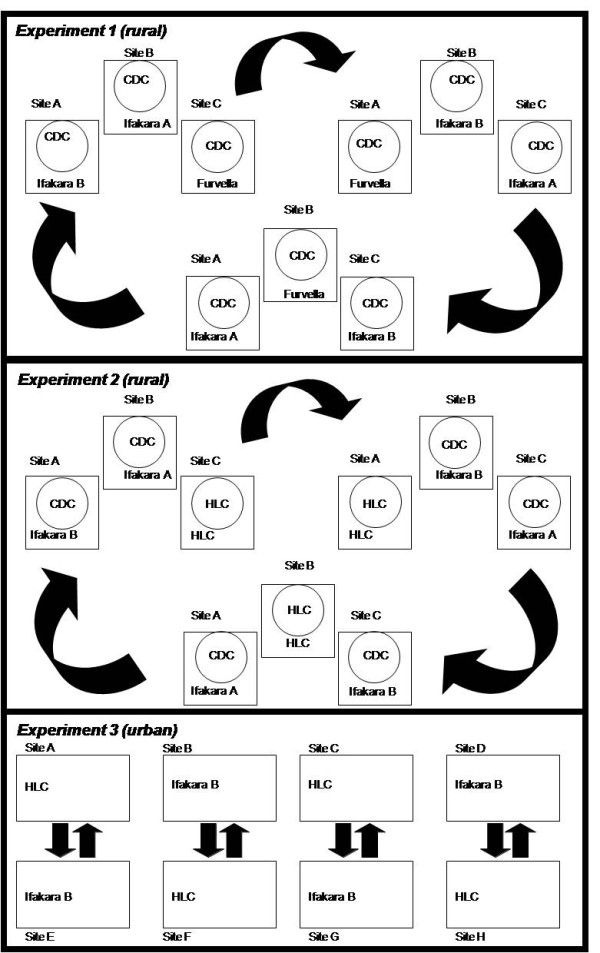
Schematic representation of a typical experimental design indicating three possible arrangements for one complete rotation in experiment one and two with cross over design in experiment three. Indoor and outdoor catching stations/sites are presented by circles and squares respectively.